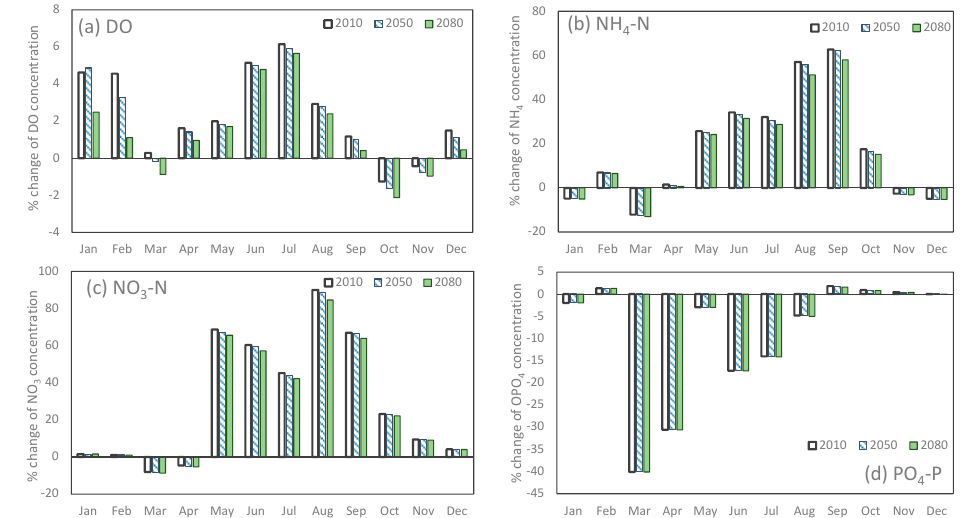
Figure 12. Changes in water quality parameters ( a ) DO; ( b ) NH 4 -N; ( c ) NO 3 -N; and ( d ) PO 4 -P due to flow increase for the RCP 8.5 scenario at the Tugaske location.